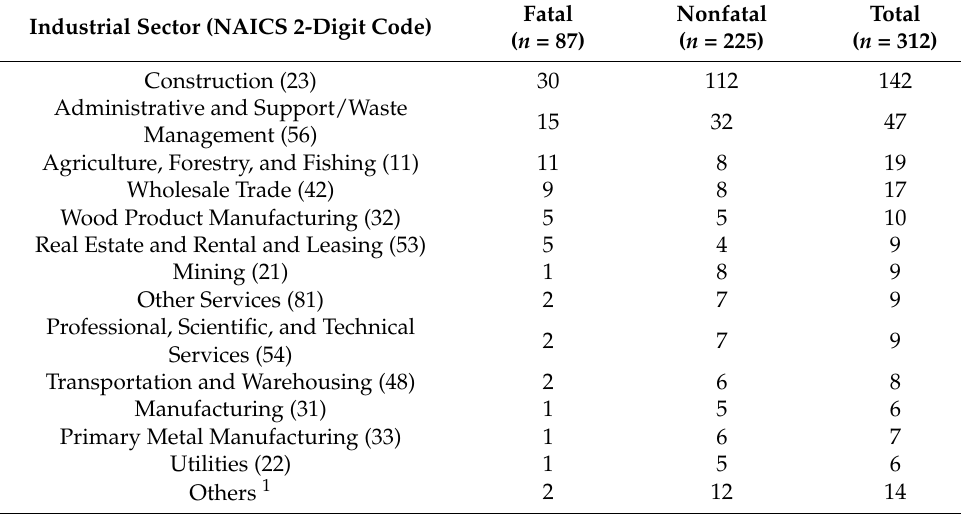
Table 1. Industrial sectors and numbers of fatal and nonfatal injuries.